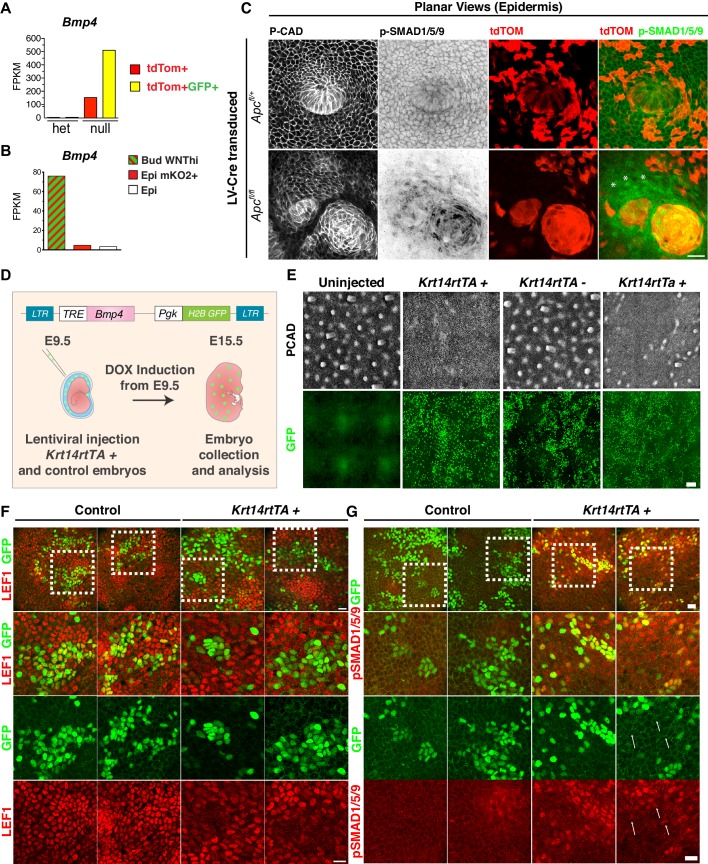
BMP4 acts long range to perturb hair follicle patterning.(A–B) Strong correlation between WNT signaling and Bmp4 levels in both (A) Apc-null clusters and (B) wild-type hair buds. (C) Whole-mount immunofluorescence of E14.5 mosaic Apc-null and Apc-het embryos. Note a halo (asterisks) of nuclear pSMAD1/5/9+ cells extending well beyond the borders of Apc-null clusters, indicative of long-range BMP signaling. Scale bar, 20 μm. (D) Experimental setup to overexpress BMP4 in skin progenitors. BMP4 is under the regulation of a tetracycline regulatory enhancer (TRE) activated by doxy-induced rtTA transcription factor binding. The lentivirus was introduced at E9.5 into the amniotic cavity of Krt14rtTA+ and Krt14rtTAneg embryos, which were then analyzed at E15.5. (E) Whole-mount images of 1 mm2 E15.5 skins of Doxy-treated Krt14rtTA+ and control (Krt14rtTAneg) littermates. Note the perturbation in patterning of hair follicles (P-Cadherin+). Scale bar, 100 μm. (F–G) Representative regions of transduced and untransduced epidermis in Krt14rtTA negative and positive littermates, (F) Note the reduced LEF1 immunostaining in GFP+ BMPhi-signaling cells. (G) Note the presence of nuclear pSMAD1/5/9 positive cells distant from the BMPhi-signaling cells (white arrows), suggestive of long-range signaling. White boxes delineate the regions that are magnified in the three images beneath each low-magnification panel. Scale bar, 20 μm.Figure 3—figure supplement 3—source data 1.Source data for the graphs shown in Figure 3—figure supplement 3A and B.